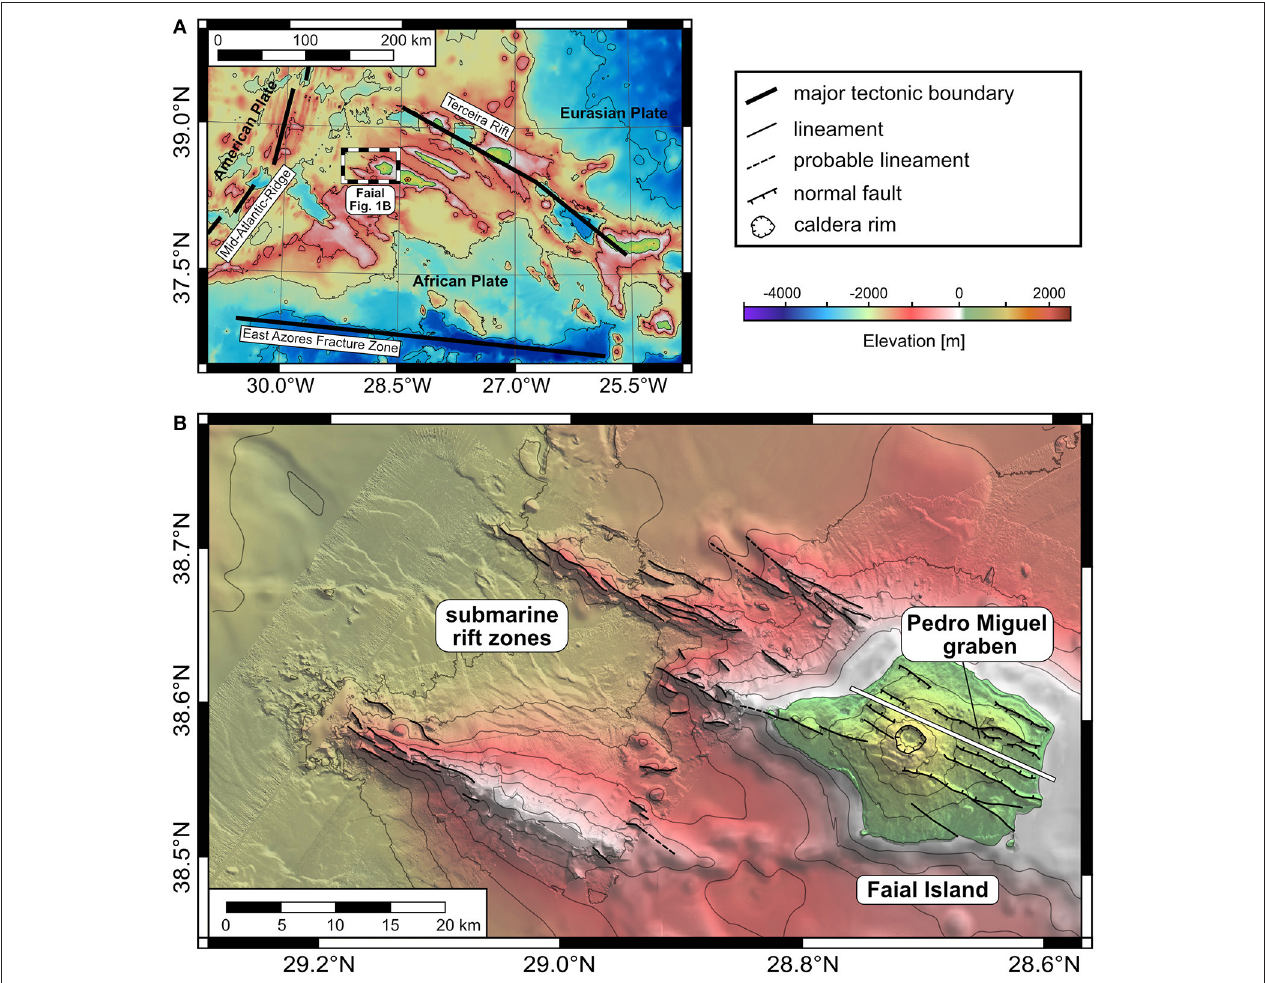
FIGURE 1 | Bathymetric maps and digital elevation models (DEM) of (A) the eastern Azores Plateau with major tectonic boundaries (contours are 1000m elevation) and; (B) Faial Island with western adjoining submarine rift zones and major structural features (contours are 250m elevation). Lineaments and faults on the